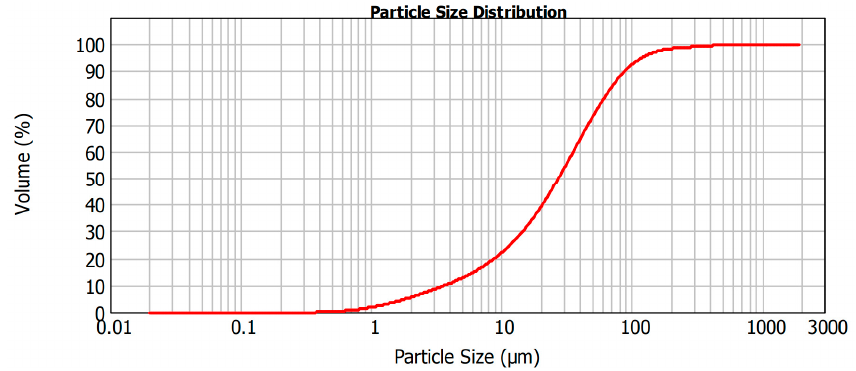
Figure 5. Multiwire gangsaw waste particle size distribution (% by weight).